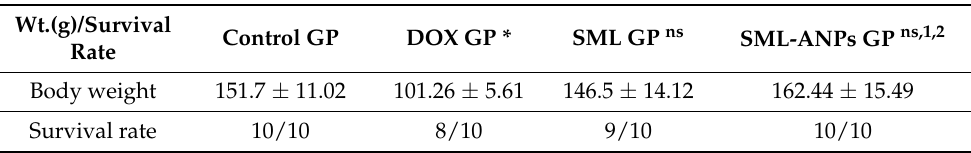
Table 3. Body weights of the experimental animals after the administration of the investigated formulations as compared to the